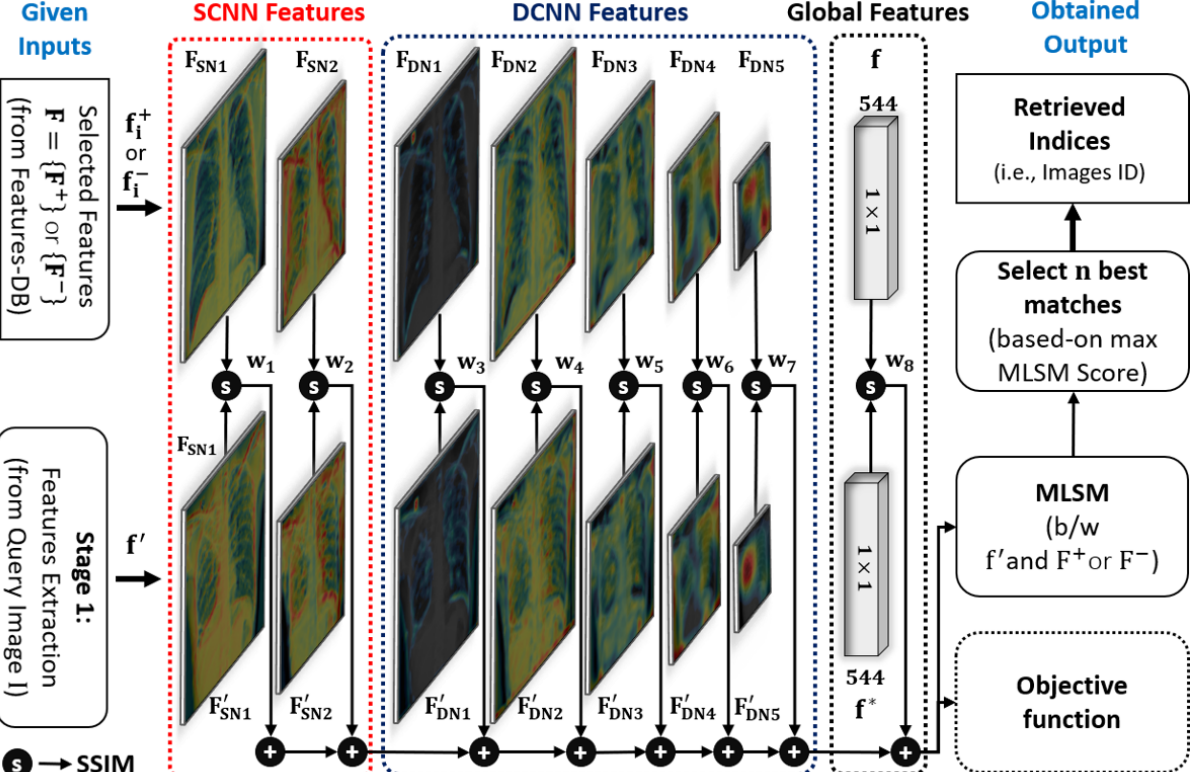
Figure 4. Complete workflow diagram of our proposed MLSM algorithm using the multilevel features (extracted from the different parts of the proposed ensemble-SDCNN model) in retrieving the best-matched cases from a previous patients’database. DCNN: deep convolutional neural network;